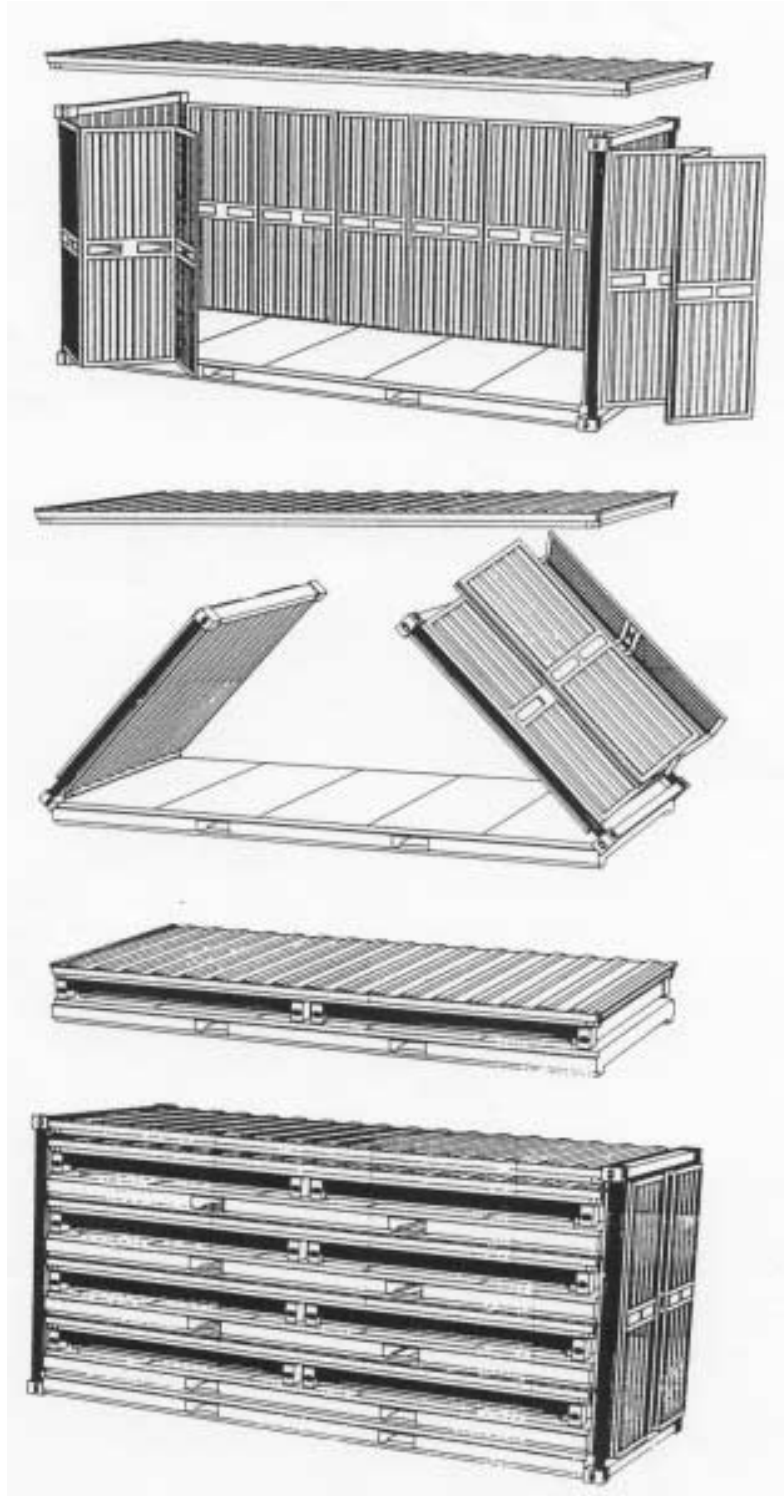
Figure 2. The folding process of the Fallpac